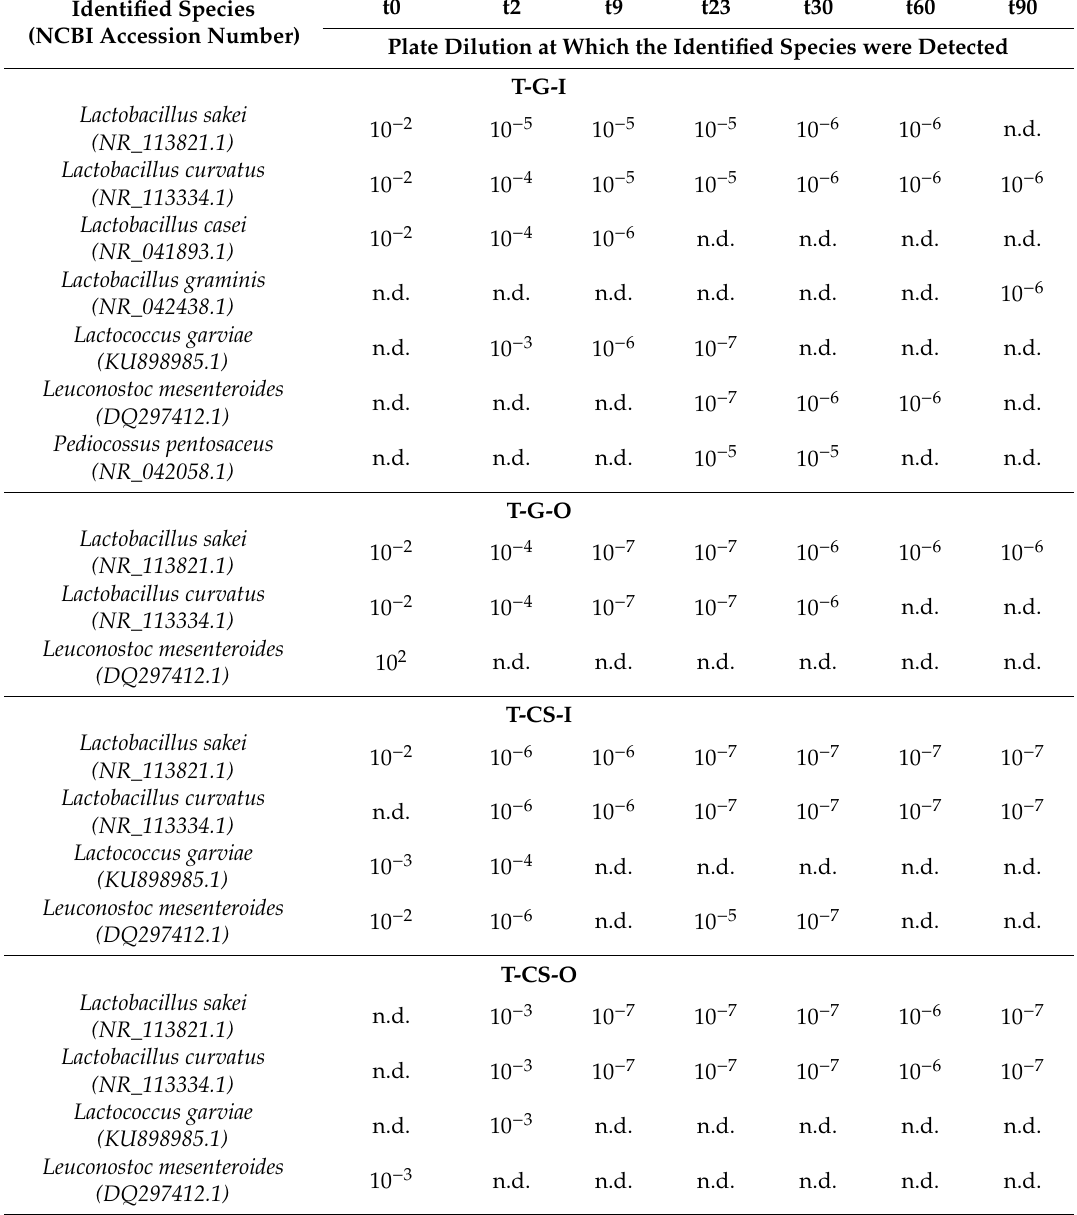
Table 3. Plate dilutions at which each identified species were detected per sampling point from the artisanal plant